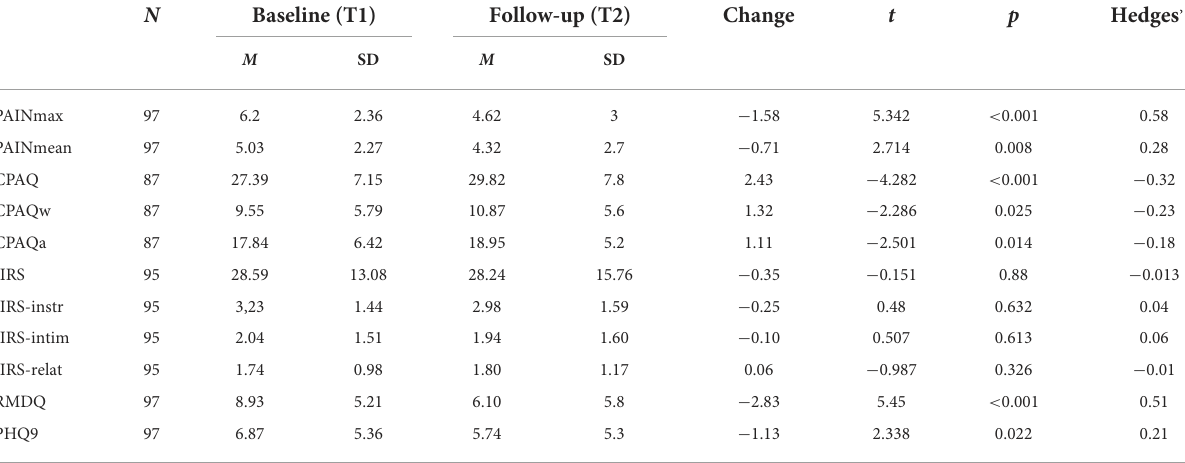
TABLE 2 The mean scores of the questionnaires at baseline and at follow-up. N Baseline